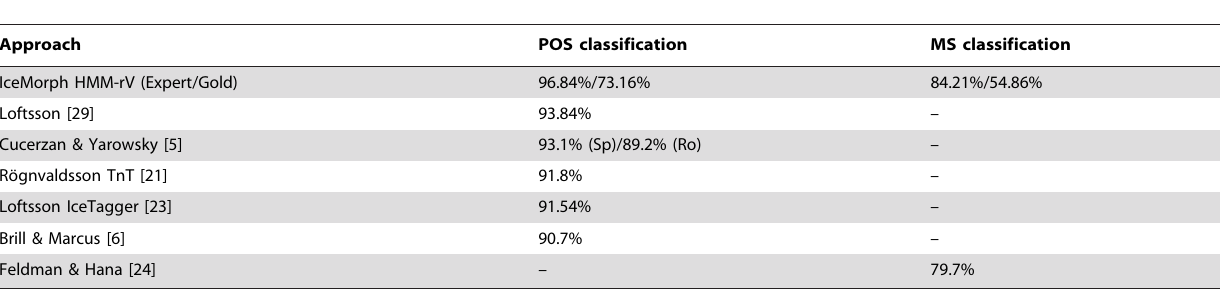
Table 1. Accuracies for different POS/MS taggers with commonalities to IceMorph.